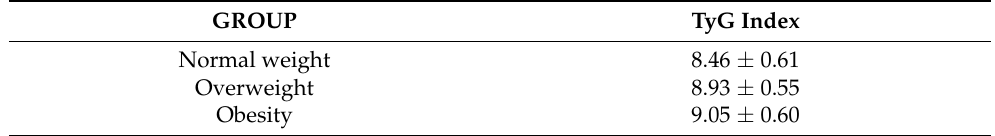
Table 2. The average value of the TyG index in the 3